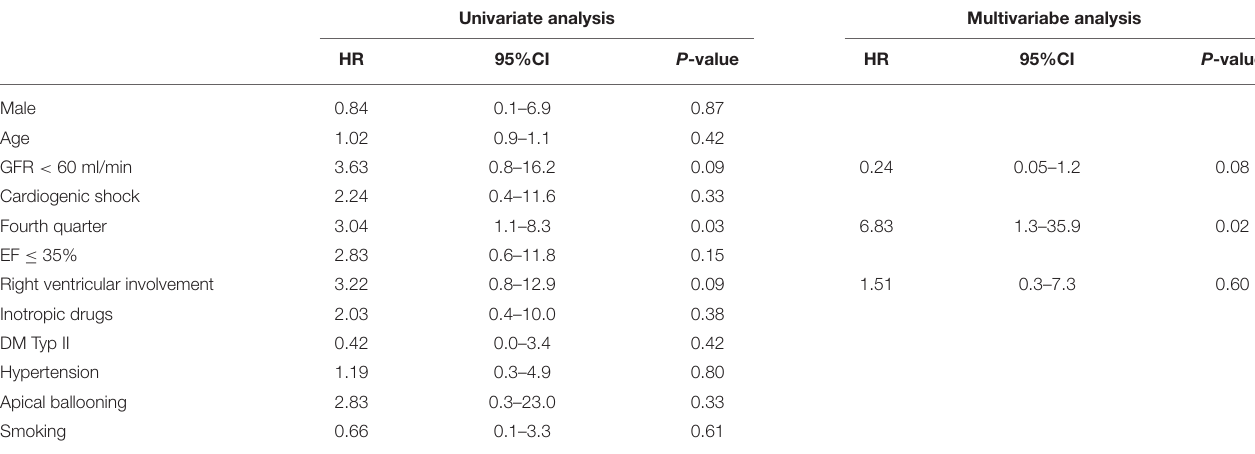
TABLE 3 | Univariate and multivariate Cox regression analysis of TTS patients reveal TTS events in the fourth quarter of year as an independent predictor with elevated risk for the composite endpoints during 1 year follow up. Univariate